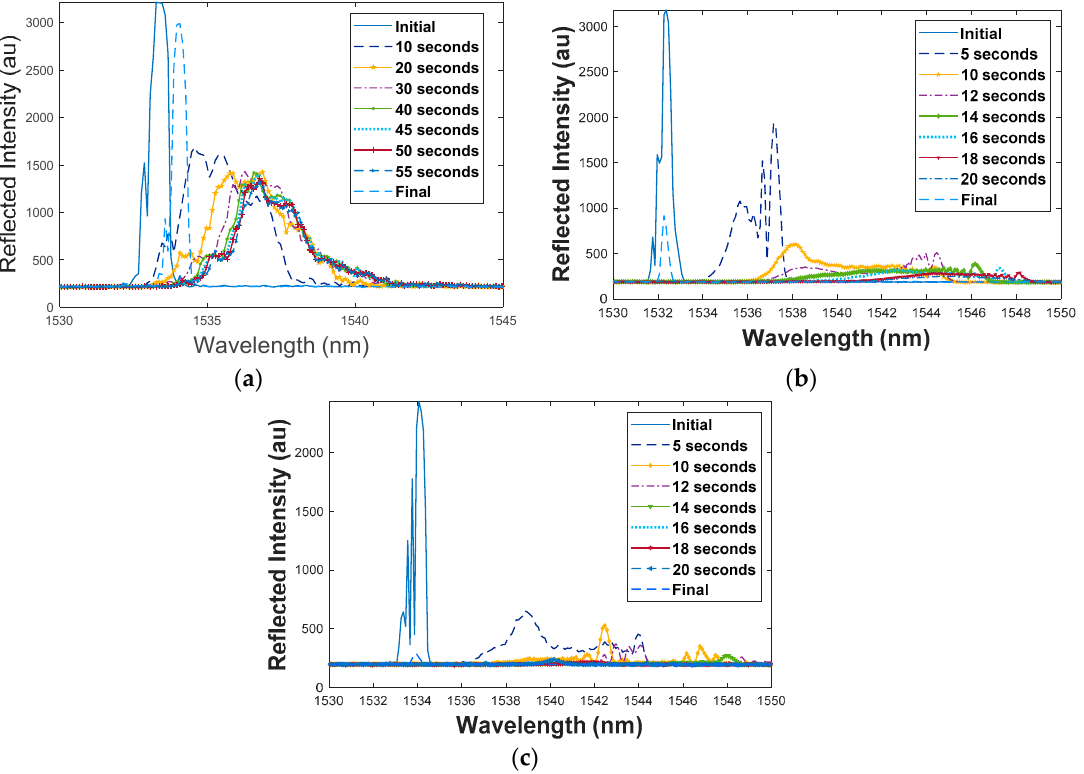
Figure 4. Two-dimensional plot of reflected spectrum over time during HEL tests: ( a ) FBG slightly degraded, ( b ) FBG moderately degraded, and ( c ) FBG severely degraded.